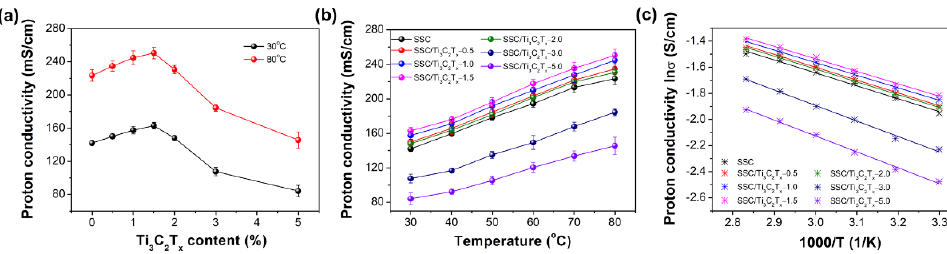
Figure 2. ( a ) Proton conductivity of short side-chain (SSC)/Ti 3 C 2 T x composite membranes in water at 30 °C and 80 °C as a function of Ti 3 C 2 T x content; and ( b ) as a function of temperature; ( c ) Arrhenius plots of proton conductivities.